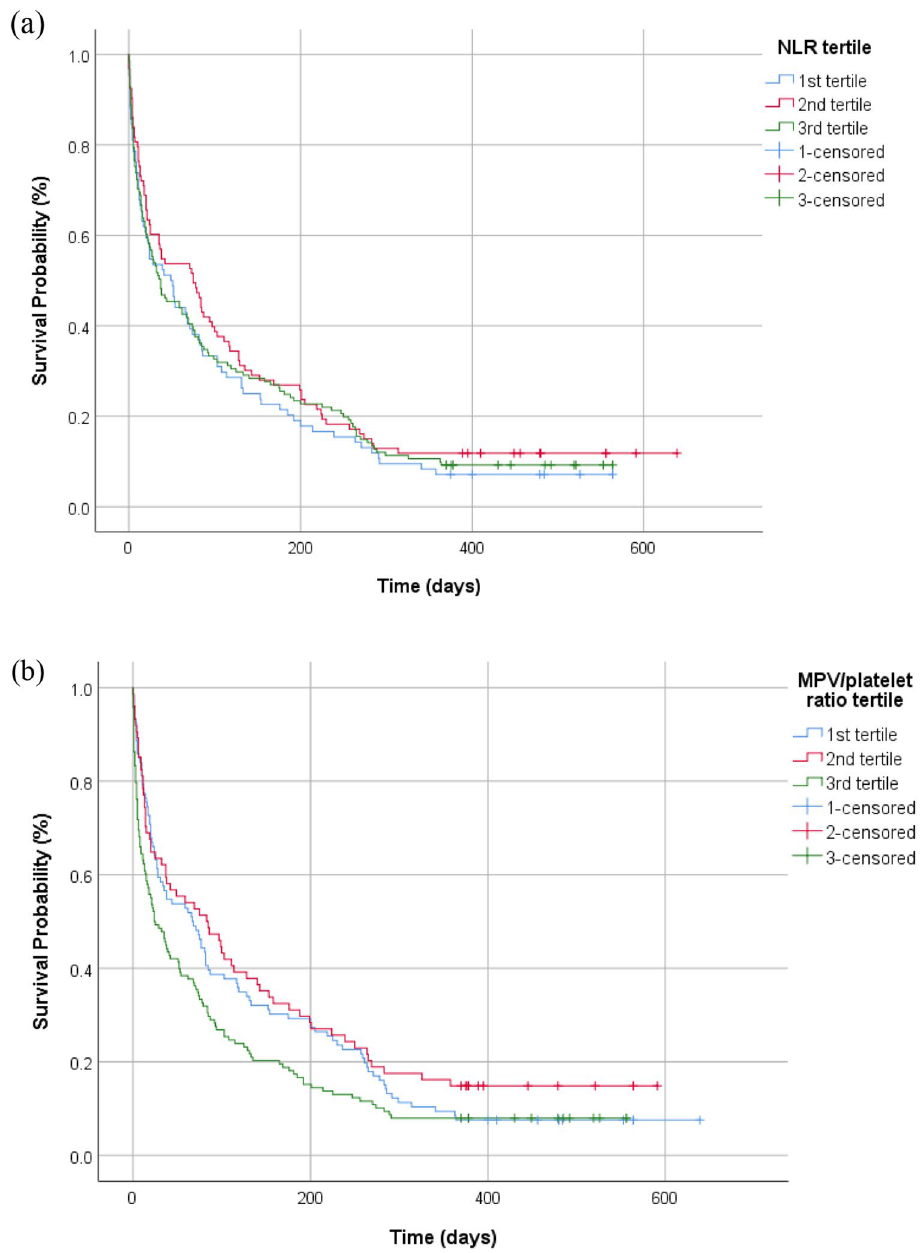
Figure 2. Kaplan–Meier survival curves for 1-year mortality according to the tertiles of neutrophil to lymphocyte ratio (NLR) (p = 0.498 based on the log-rank test) ( a ) and mean platelet volume (MPV)/platelet ratio (p = 0.015 based on the log-rank test) ( b